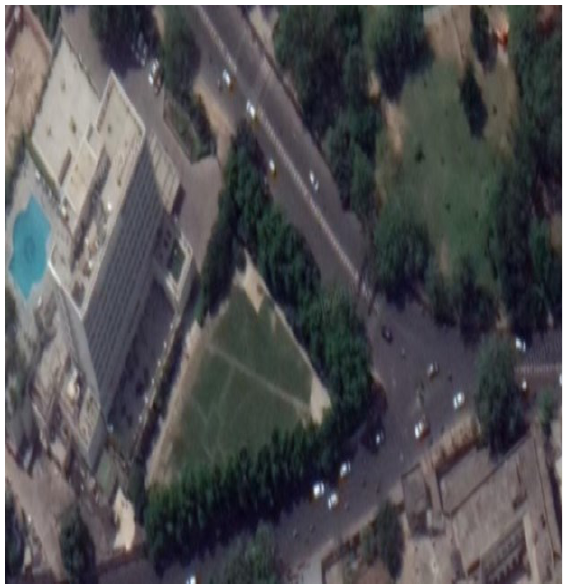
Figure 3. Image to show feature extraction using ML algorithm